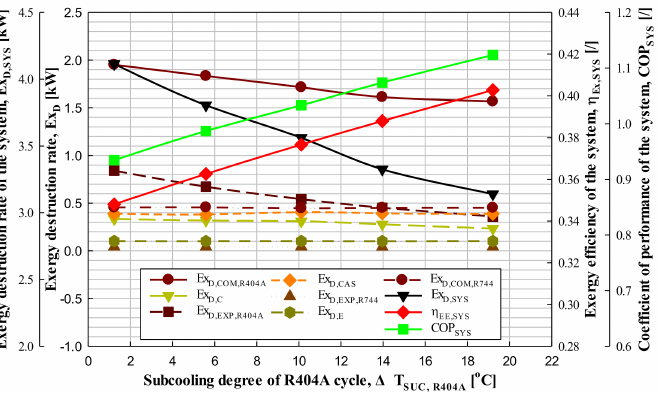
Figure 4. Exergy destruction rate, exergy efficiency and COP of the CRS with respect to subcooling degree of R404A